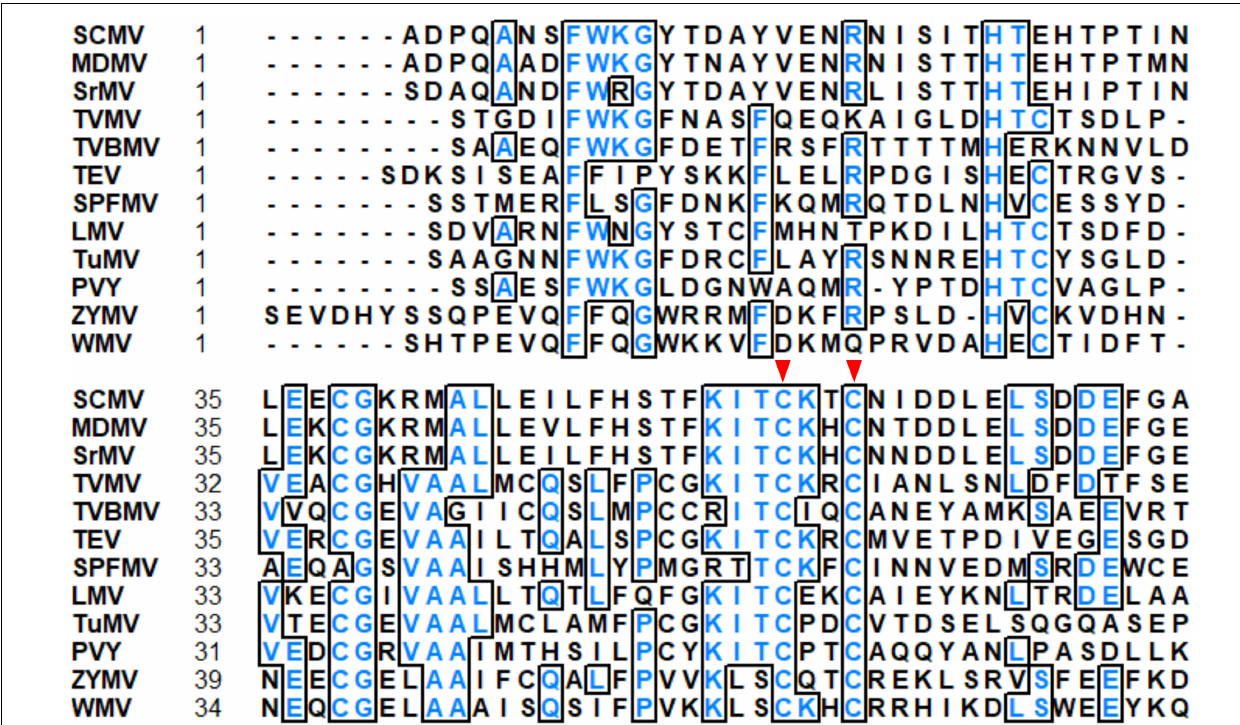
FIGURE 1 | Alignment of partial HC-Pros sequences of 12 potyviruses. The highly conserved cysteine residues at positions 57 and 60 (C 57 and C 60 ) in SCMV HC-Pro were pointed by the red triangles. The analysis was performed with the sequences of SCMV (GenBank accession: AY042184), maize dwarf mosaic virus (MDMV, GenBank accession: AJ001691), sorghum mosaic virus (SrMV, GenBank accession: U57358), tobacco vein mottling virus (TVMV, GenBank accession: NP_734329), tobacco vein banding mosaic virus (TVBMV, GenBank accession: EF219408), tobacco etch virus (TEV, GenBank accession: DQ986288), sweet potato feathery mottle virus (SPFMV, GenBank accession: KU511268), lettuce mosaic virus (LMV, GenBank accession: AJ306288), turnip mosaic virus (TuMV, GenBank accession: AB093596), potato virus Y (PVY, GenBank accession: AB185833), zucchini yellow mosaic virus (ZYMV, GenBank accession: AY188994) and watermelon mosaic virus (WMV, GenBank accession: